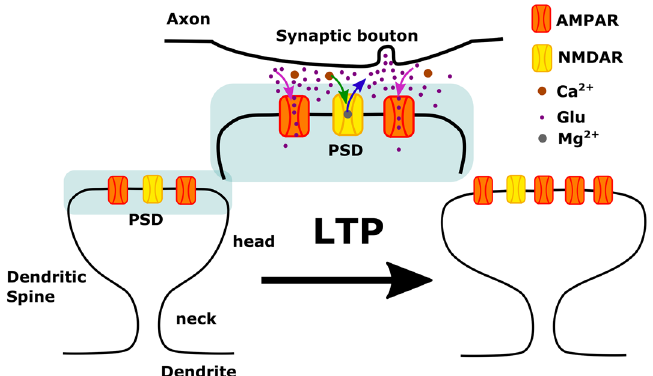
Figure 1. Long-Term Potentiation (LTP) in dendritic spines. AMPA receptors (orange) located at the postsynaptic density (PSD) in mature dendritic spines (left) are activated (magenta arrows) by Glutamate (Glu, purple circles) released from the synaptic bouton in the axon of the presynaptic neuron. When the AMPA receptors are strongly stimulated, the postsynaptic cell is depolarized causing the release (blue arrow) of the 2 Magnesium ion (Mg , gray circle) that blocks the NMDA receptor (yellow), allowing the entry of calcium 2 + (Ca , brown circles) to the spine. This process is known as LTP induction (middle) and triggers an increase